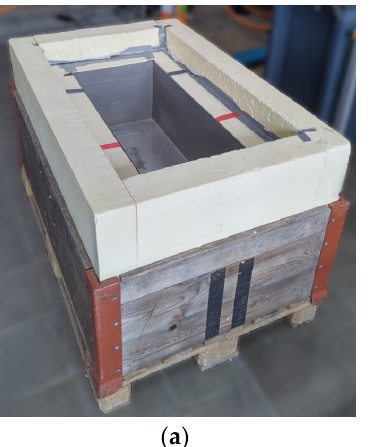
Figure 5. Test stand insulation and tank ( a ) with lid and pump ( b ).